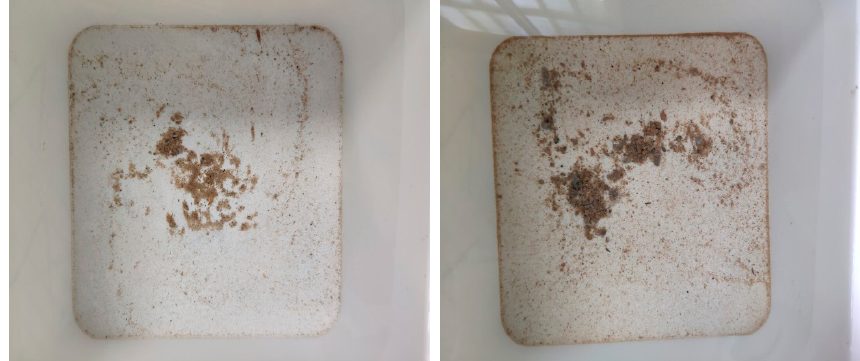
Figure 8. Change in fine gravel content in the corrosive liquid drum.